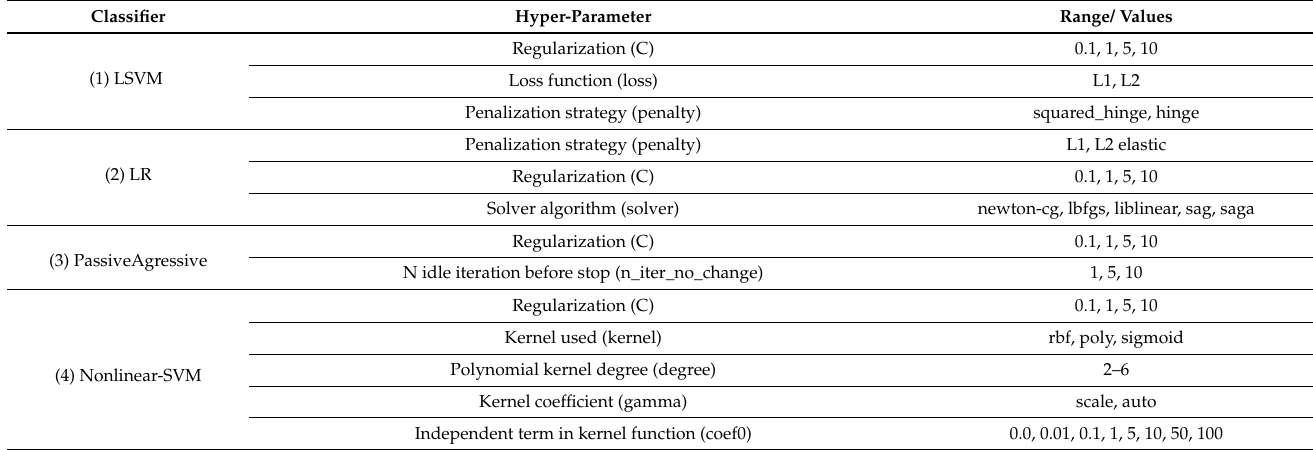
Table 1. Used hyper-parameter values in a cross-validated grid search. Names between parentheses are parameter names in the ML